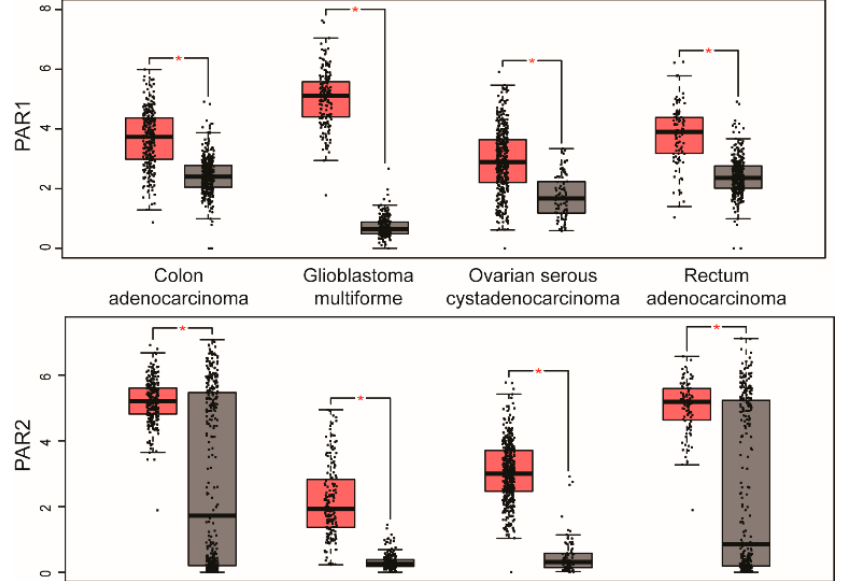
Figure 2. Human cancers with significant PAR1 and PAR2 overexpression. A survey of cancers using GEPIA analysis revealed several cancer types with only PAR1 and PAR2 overexpression compared to normal tissue, including colon adenocarcinoma (275 tumor, 349 normal), glioblastoma multiforme (163 tumor, 207 normal), ovarian serous cystadenocarcinoma (426 tumor, 88 normal), and rectum adenocarcinoma (92 tumor, 318 normal). The RNA-seq data are expressed as the relative gene expression using transformed log 2 (TPM+1) value ( Y -axis) of tumor (red) and normal (grey) in different cancer types and displayed as whisker plots as described in Figure 1. The data showed a significant difference in PAR1 and PAR2 expression in tumors compared to normal tissue using one-way ANOVA (* p < 0.01). In addition to PAR upregulation, analysis of PAR expression indicates that certain PARs are downregulated in various cancer types. PAR1 and PAR2 are both significantly downregulated in kidney chromophobe, whereas only PAR1 is downregulated in kidney renal papillary cell carcinoma and PAR2 is only downregulated in skin cutaneous melanoma (see Figure 3 and Table 1). Intriguingly, PAR4 shows greater prevalence of downregulation in five different cancer types, namely acute myeloid leukemia, lung adenocarcinoma, lung squamous cell carcinoma, testicular germ cell tumors and thyroid